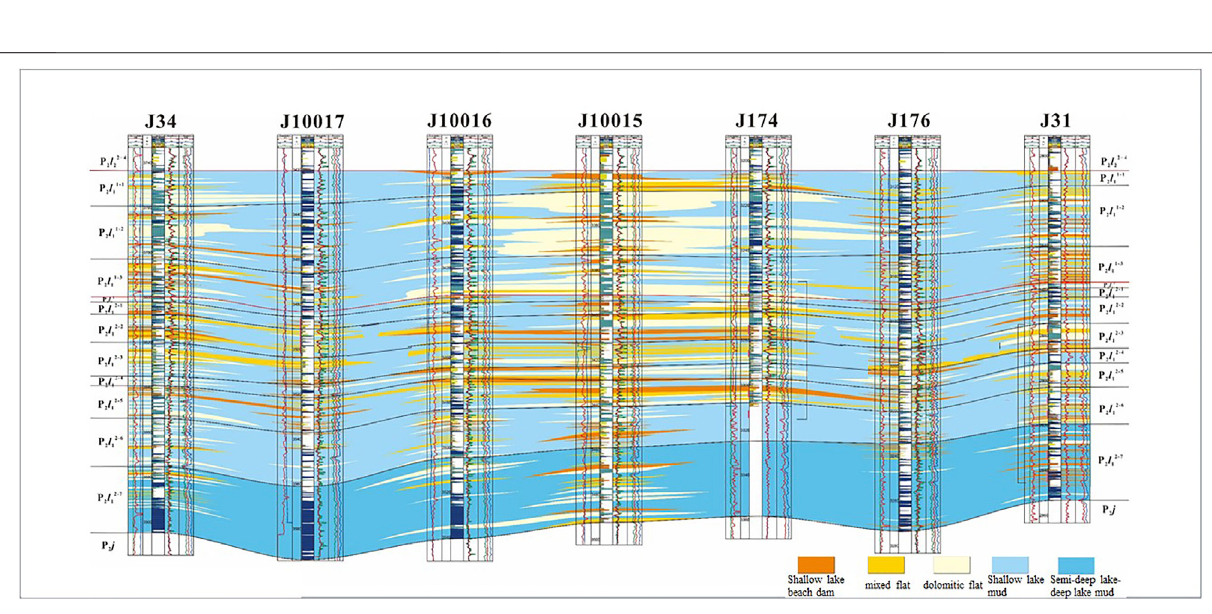
Frontiers in Earth Science |